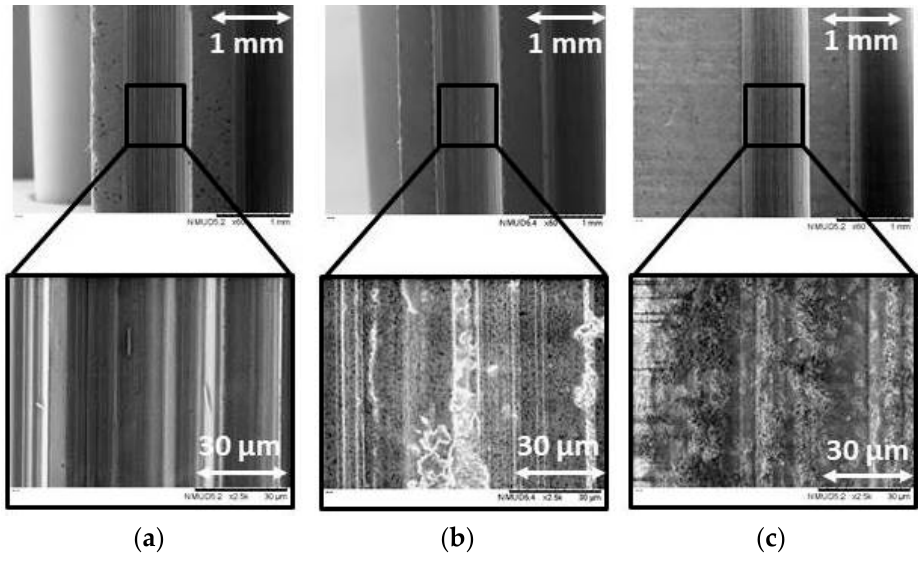
Figure 4. SEM analysis of the ground bioceramics under magnifications 60× and 2500×, i.e., for ( a ) ZrO 2 , ( b ) ATZ and ( c ) ZTA specimens. The bioceramics were machined with process condition P1, i.e., v c = 18.33 m/s, v f = 300 mm/min, and a e = 250 μ m.